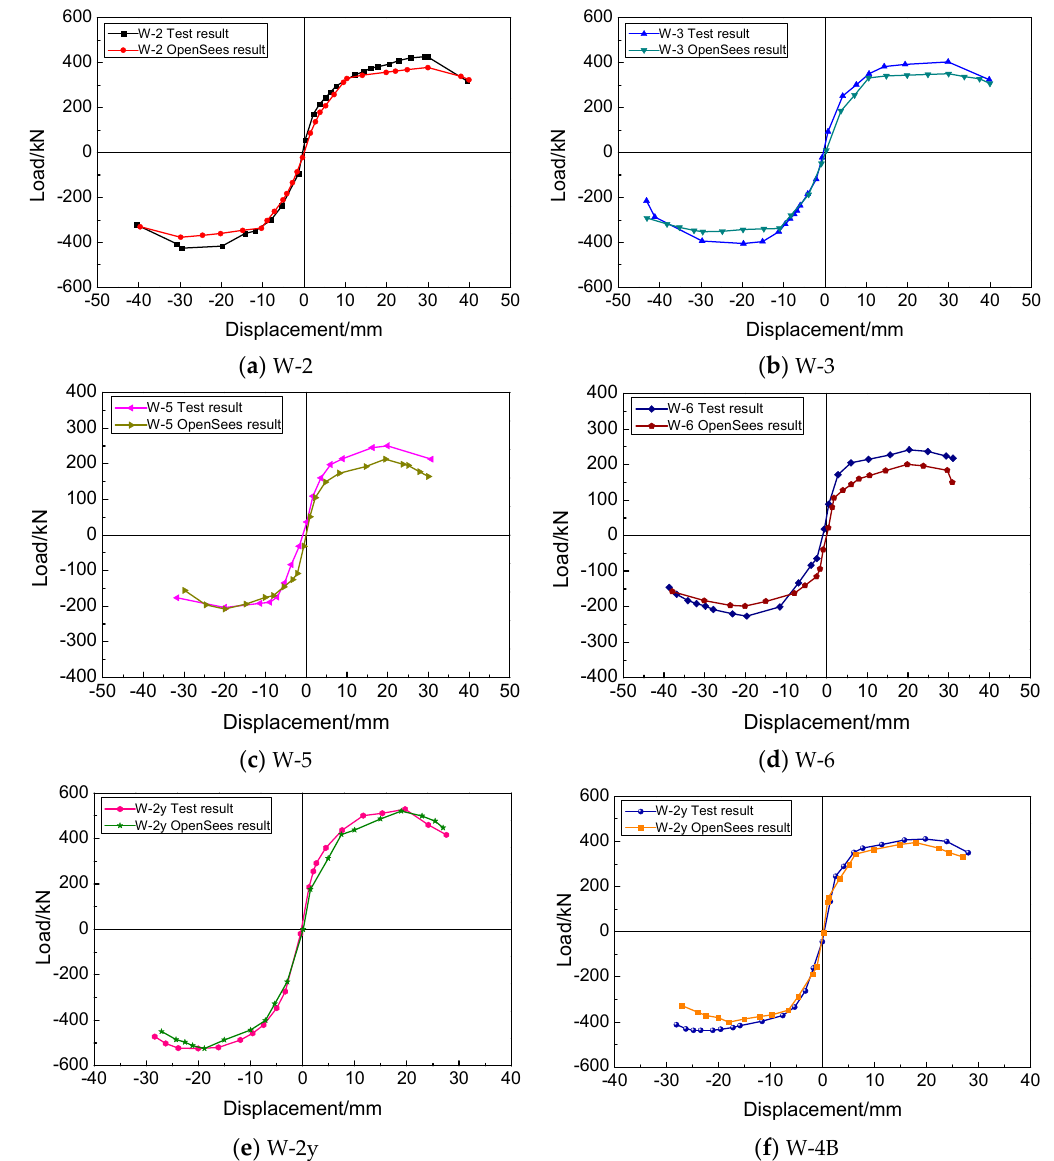
Figure 9. Comparison of the test results and the calculated results of the backbone curves.